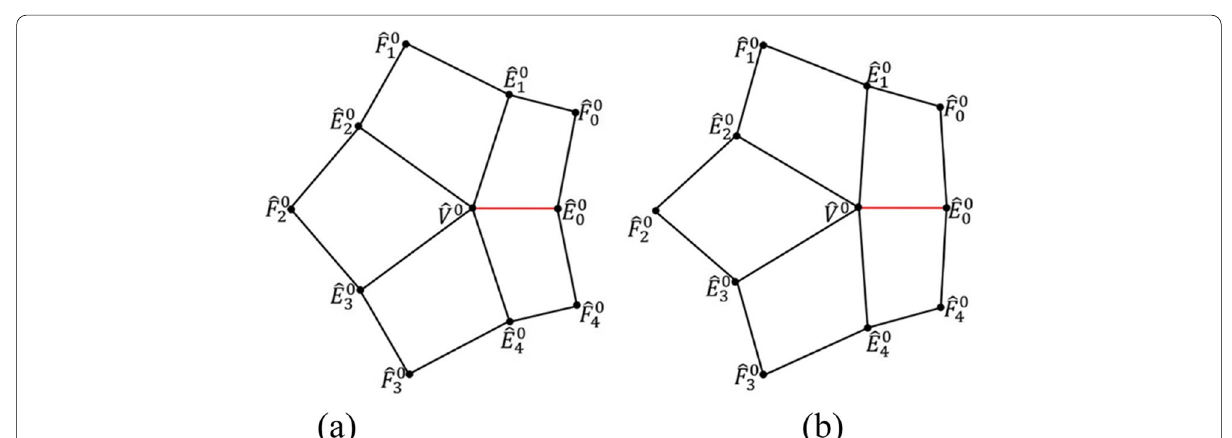
Fig. 5 An eigenpolyhedron for a valence-5 EP, where the black edges have knot intervals of 10, and the red edge has knot intervals of 1. a Using the approach in ref. [7]; b Using the proposed